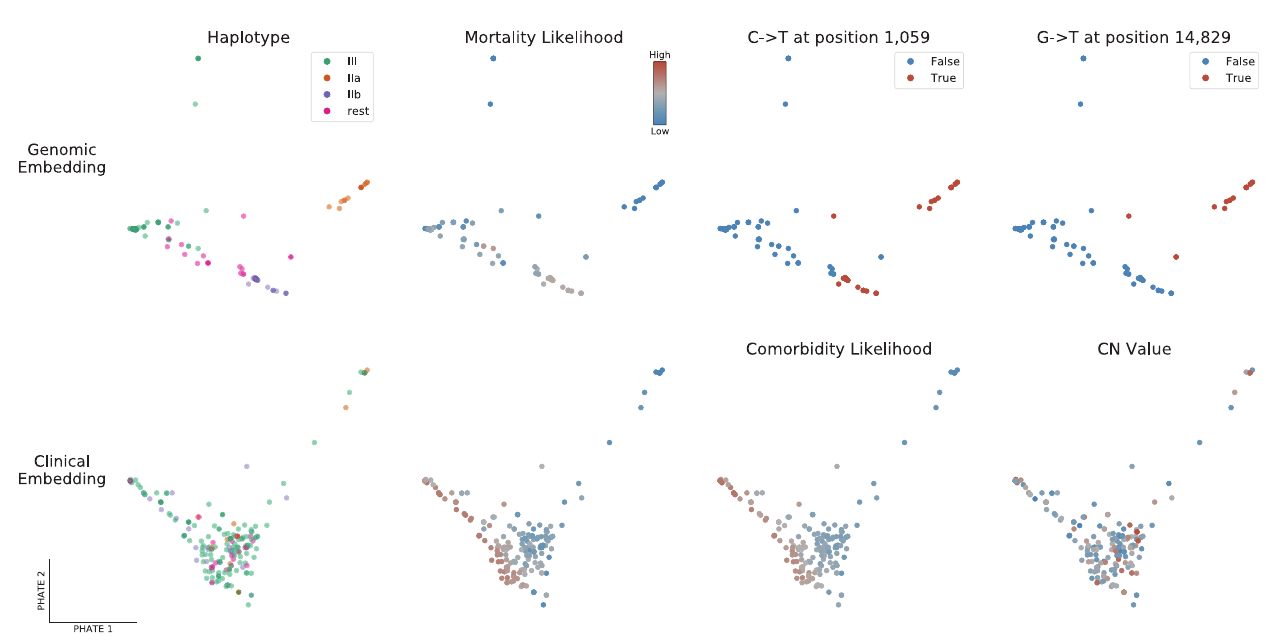
Fig 4. PHATE embeddings of genomic and clinical features. Two-dimensional PHATE embeddings of the genomes (Top) and of the clinical features (Bottom). Each marker represents one patient and the embedding location of a given patient indicates feature similarity with surrounding samples as well as dissimilarity with distant ones. The embeddings are unsupervised and the labels of interest are used for coloring only. Specifically, mortality and comorbidity likelihoods were computed using MELD [23], a graph signal processing tool used to smooth a binary variable on the patient-patient graph to determine which regions of its underlying data manifold are enriched or depleted in patients with a specific